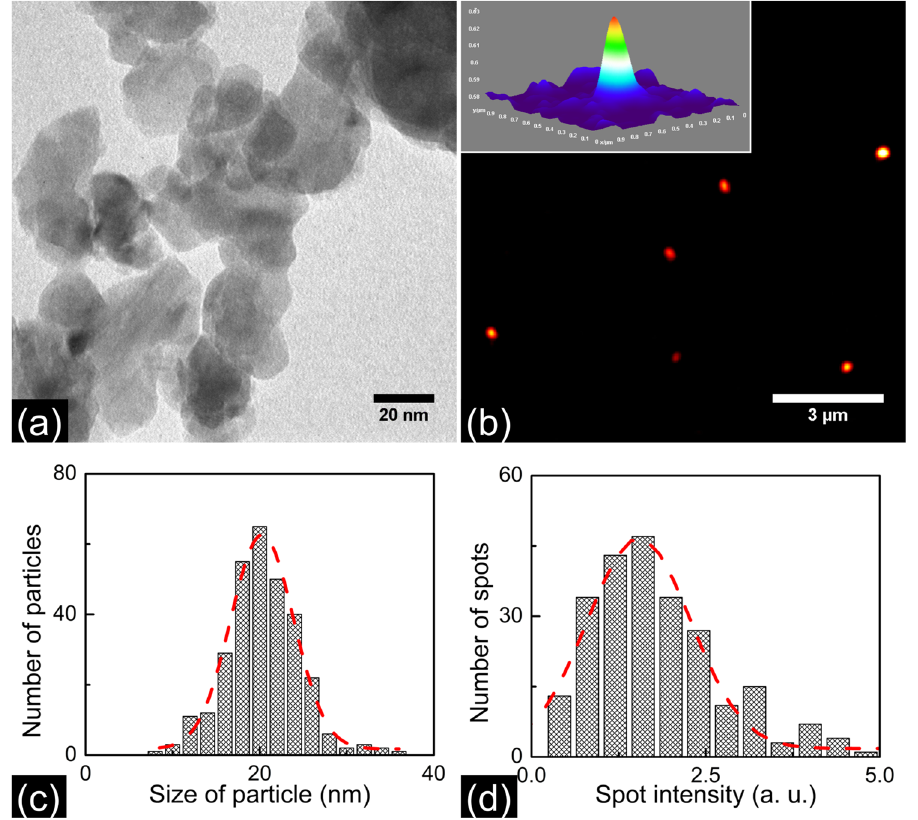
Figure 2. ( a ) TEM image of BaTiO 3 nanoparticles prepared by sol-gel technique. ( b ) Photothermal image of 20 nm BaTiO 3 nanoparticles spin coated on a coverslip at 4000 rpm for 30 s. The pump power and probe power used are 8 mW and 0.8 mW respectively. Inset shows pseudo 3D image of single 20 nm BaTiO 3 nanoparticle. The SNR in the images shown is 19. ( c ) Particle size distribution of BaTiO 3 nanoparticle measured from the TEM images. The dotted line shows a Gaussian curve fit. The average size of BaTiO 3 nanoparticles is 20 nm. The percentage distribution in size is found to be (18 ± 2)%. ( d ) Two-photon photothermal intensity histogram of BaTiO 3 nanoparticles. The percentage distribution in intensity is found to be (49 ±